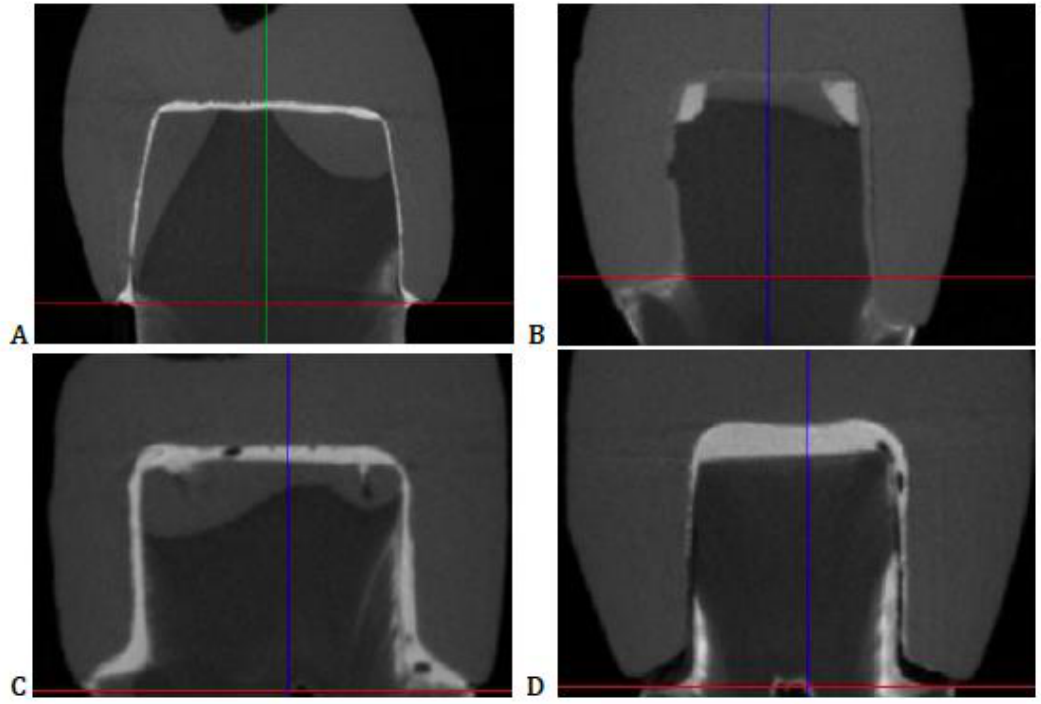
Figure 3. MicroCT images of the assessed samples in groups ( A ) Cast/LWT, ( B ) CAD-CAM, ( C ) DLP-Cast, and ( D ) SLM.